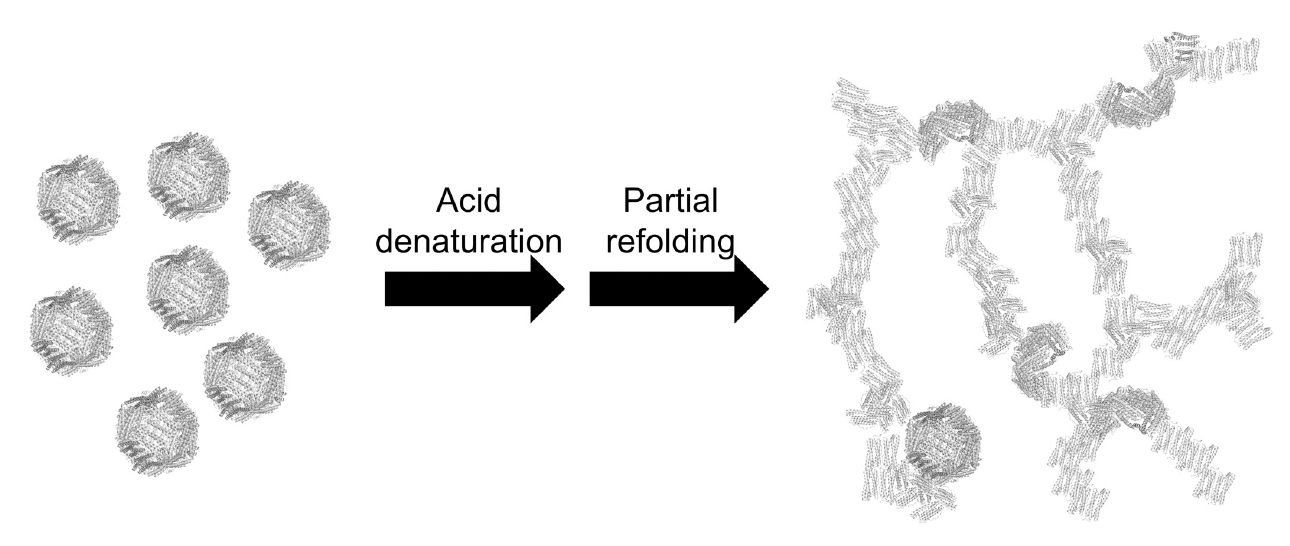
Fig 8. Schematic image of apoferritin hydrogel